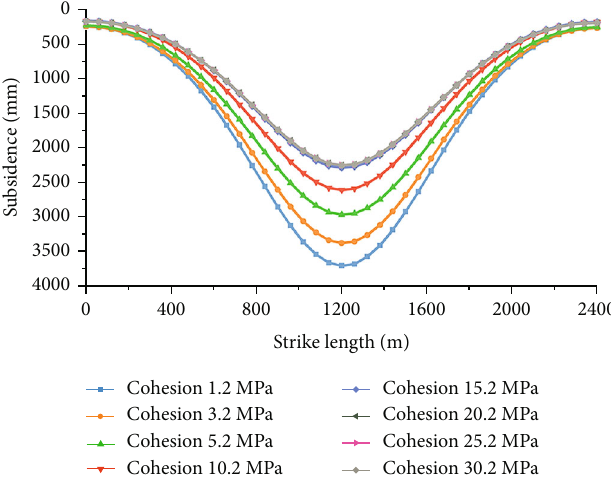
Figure 16: Surface subsidence curve of di ff erent cohesion in strike direction. 0.9934000 W = 1854.91 ⁎ exp (– c /6.21) + 2201.23 3500 R 2 =